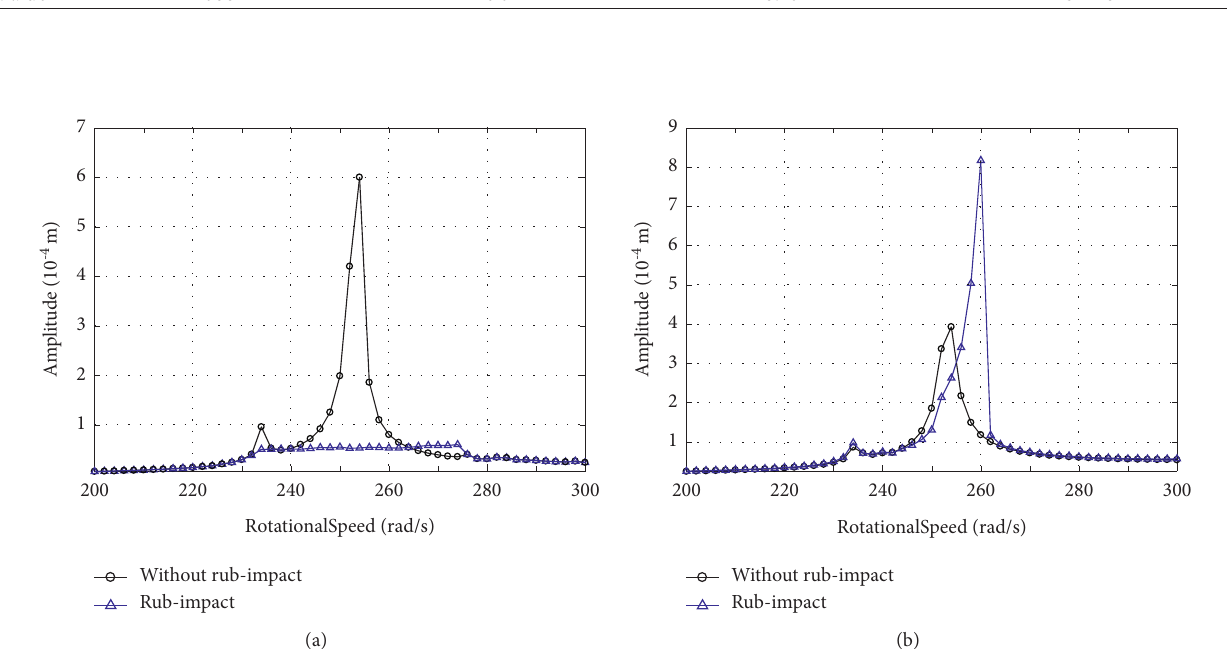
Figure 10: Lateral vibration response of disk 4 with or without rub-impact. (a) Level flight. (b) Hovering flight.